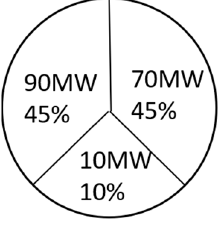
Figure 2. Schematic view of the roulette